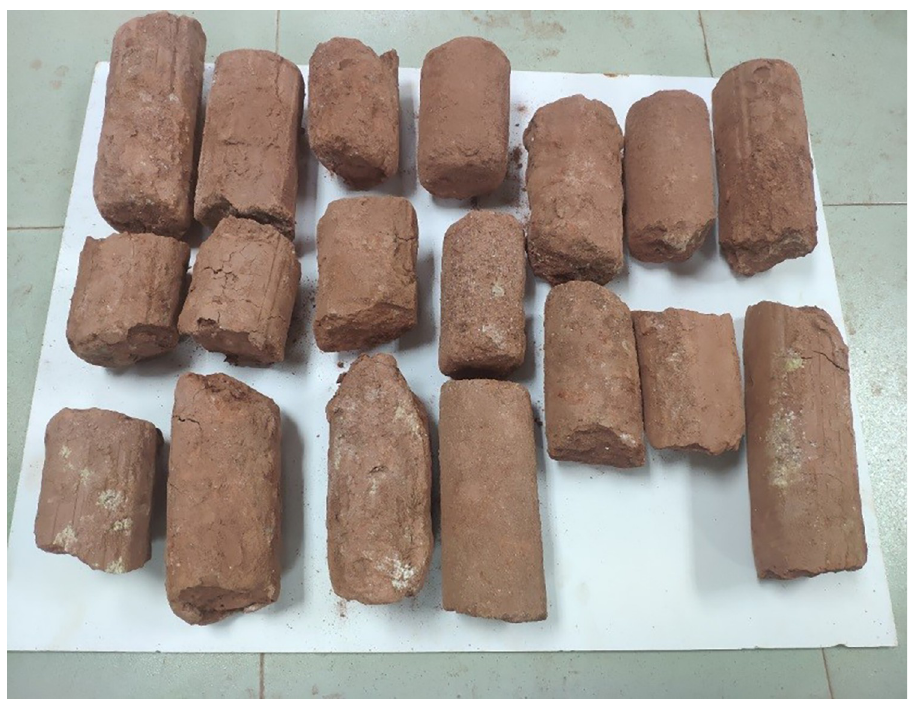
Fig 1. Naturally Weathered Red-Bed Soil Sample (A) No. 1; (B) No. 2; (C) No. 3; (D) No. 4; (E) No. 5; (F) No. 6 (G) No. 7; (H) No. 8; (I) No. 9.